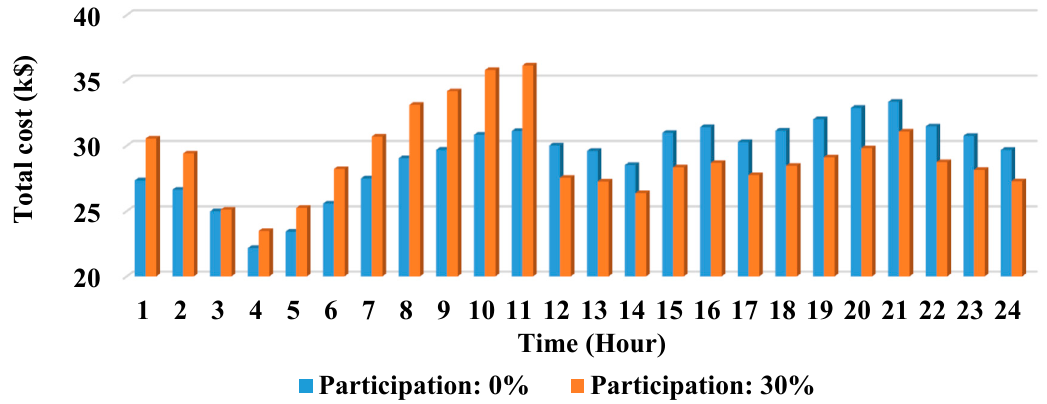
Figure 20. The system cost with and without demand response for a typical day in week 40.